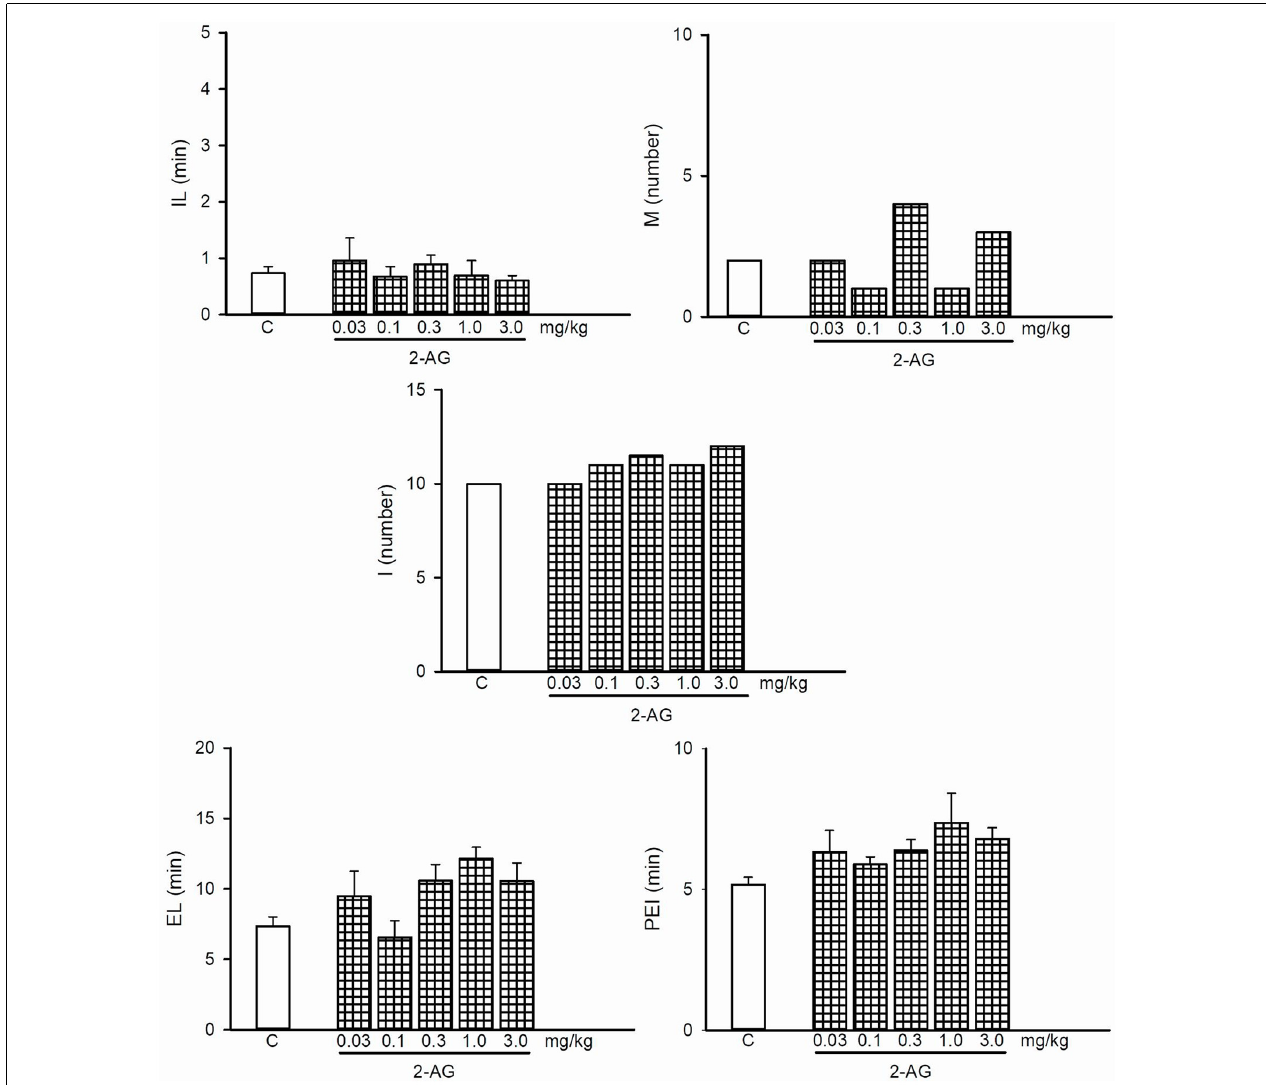
FIGURE 3 | Dose-response curve of the effects of different doses of 2-arachidonoylglycerol (2-AG; 0.03–3.0 mg/kg, n = 8 each) or vehicle (C) on the specific sexual behavior parameters of sexually experienced male rats. IL, intromission latency; M, number of mounts; I, number of intromissions; EL, ejaculation latency; PEI, postejaculatory interval. Latencies are expressed in minutes, as mean ± SEM, and numbers as